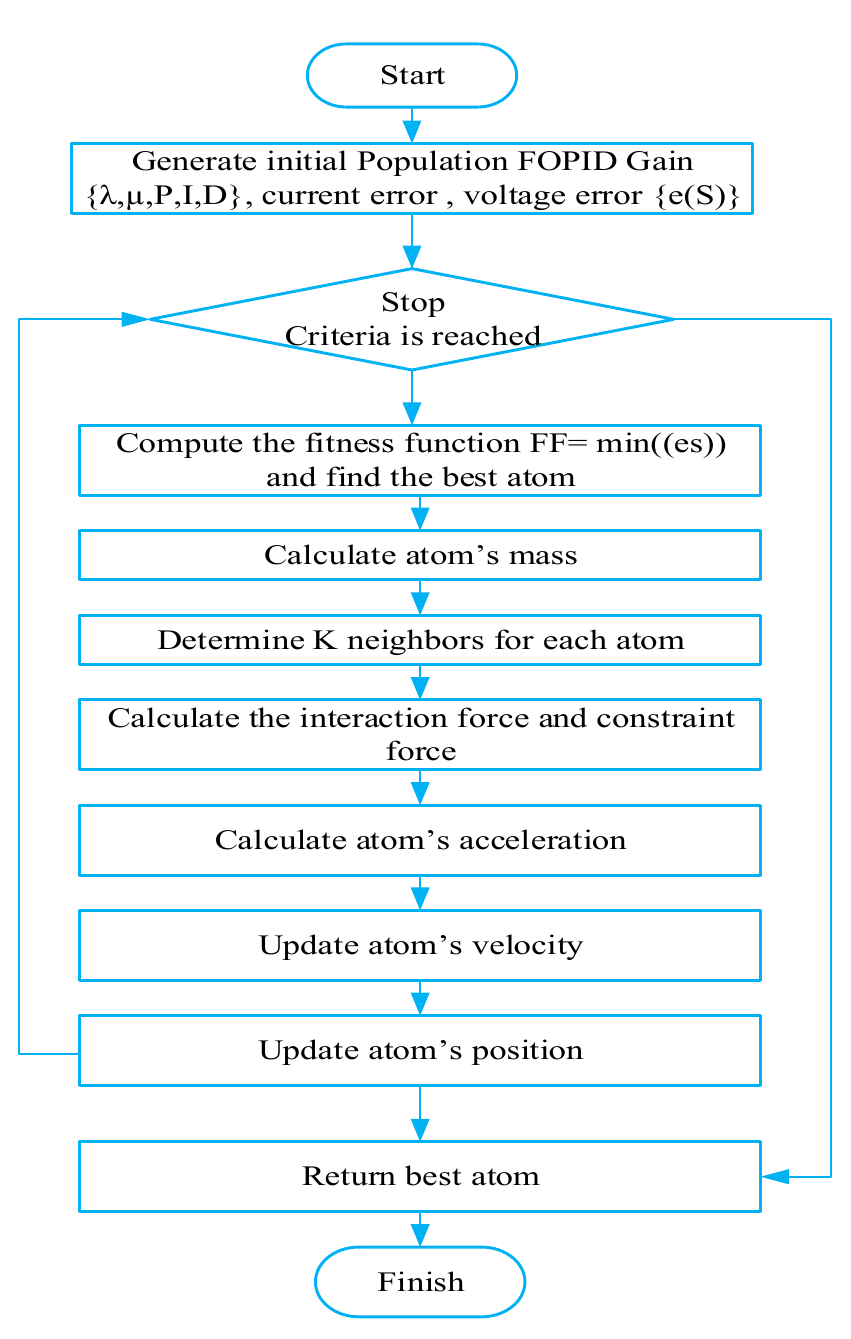
Figure 8. Flow chart of ASO technique.